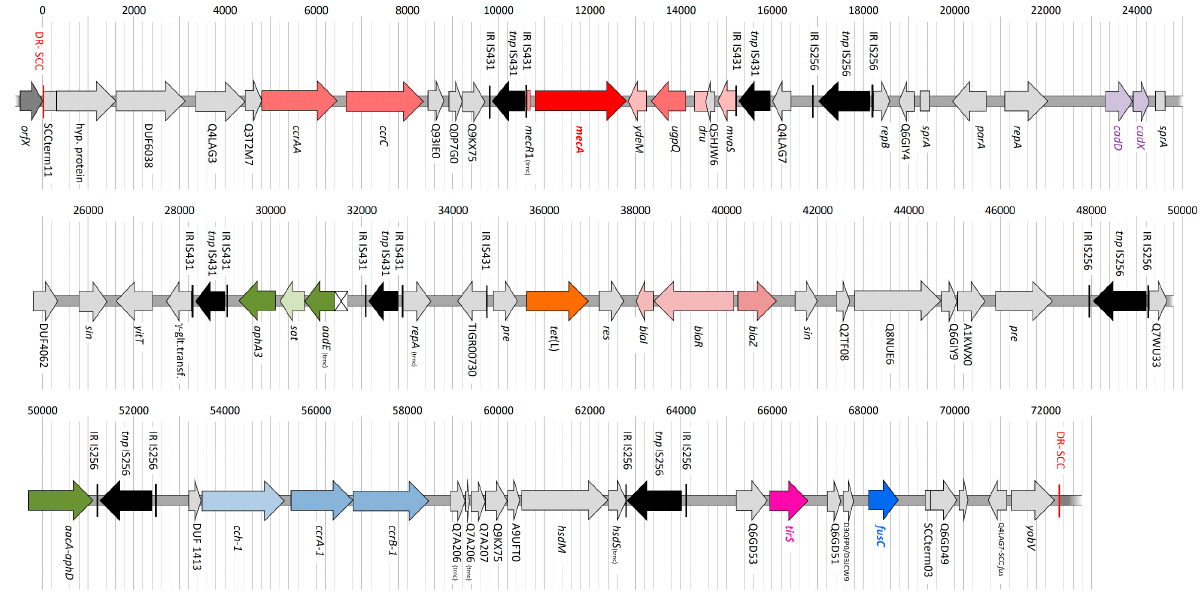
Figure 1. Schematic representation of the SCC mec [V+ fus+tir+ccrA/B -1] element from a CC1 isolate (GenBank CP113244.1).